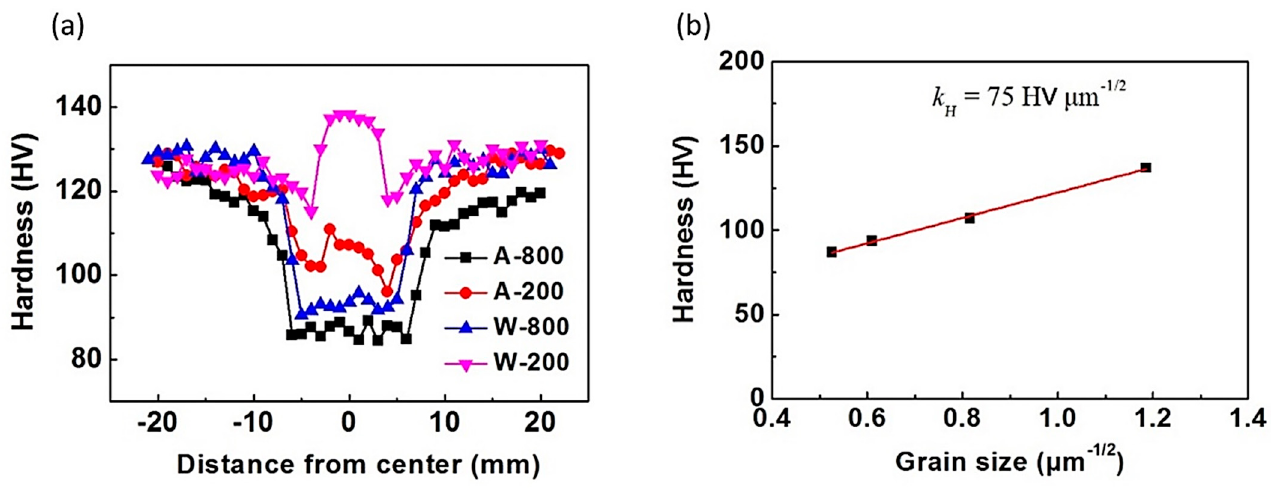
Figure 20. ( a ) Microhardness profiles of the FSWed joints at a rotational speed of 800 and 200 rpm with (W) and without (A) using water cooling, ( b ) Relationship between Vickers hardness and average grain size in the stir zone of various FSWed joints [175]. Reprinted from: Enhanced mechanical properties of friction stir welded 5083Al-H19 joints with additional water cooling. Journal of materials science & technology 33, no. 9 (2017): 1009–1014, Wang, B. B., F. F. Chen, F. Liu, W. G. Wang, P. Xue, and Z. Y. Ma, Copyright 2017, with permission from Elsevier.